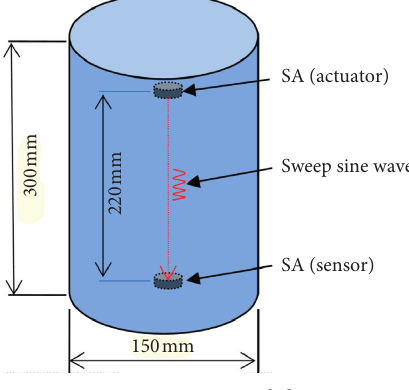
Figure 3: Experimental